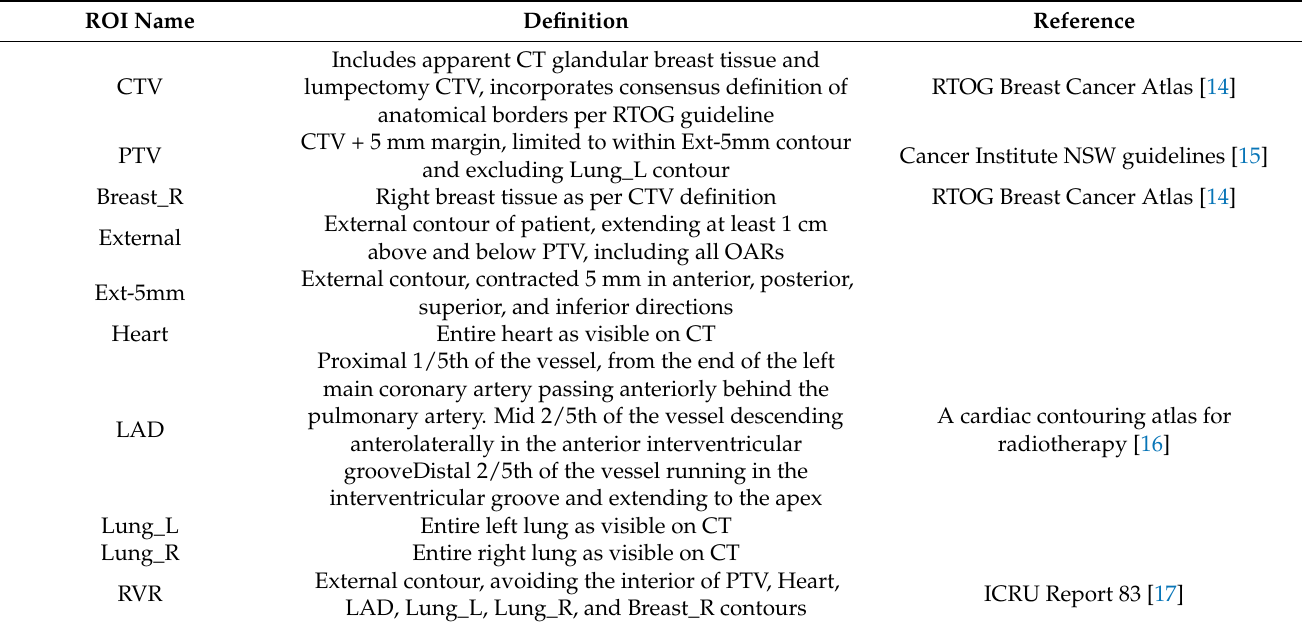
Table A1. List of regions of interest and anatomical definitions used in plan